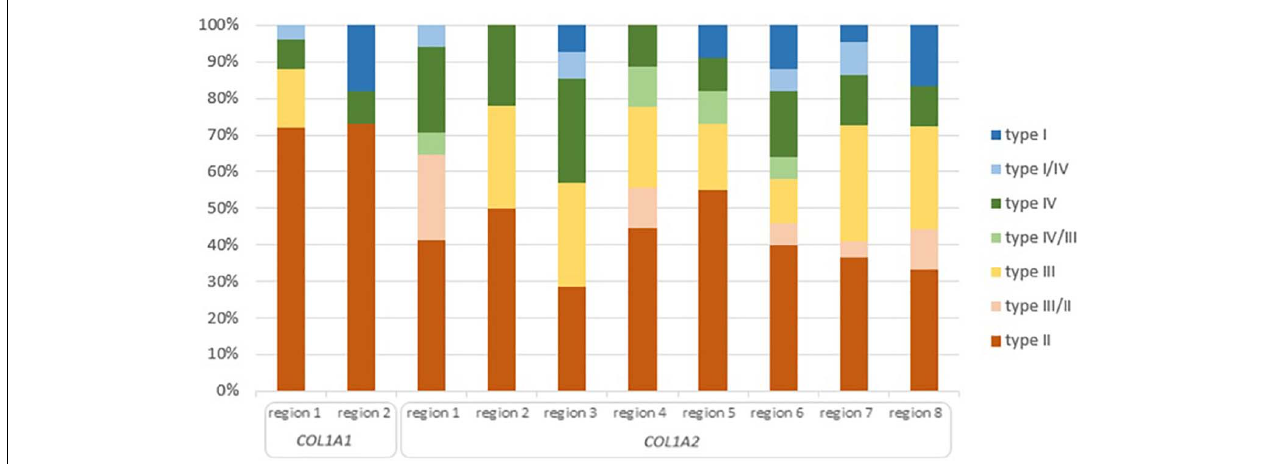
FIGURE 4 | Clinical severity of glycine substitutions reported in the lethal regions of collagen type I genes. Each type of OI refers to different color seen in the legend. High of the bars reflect percentage participation of particular OI type in each lethal region.